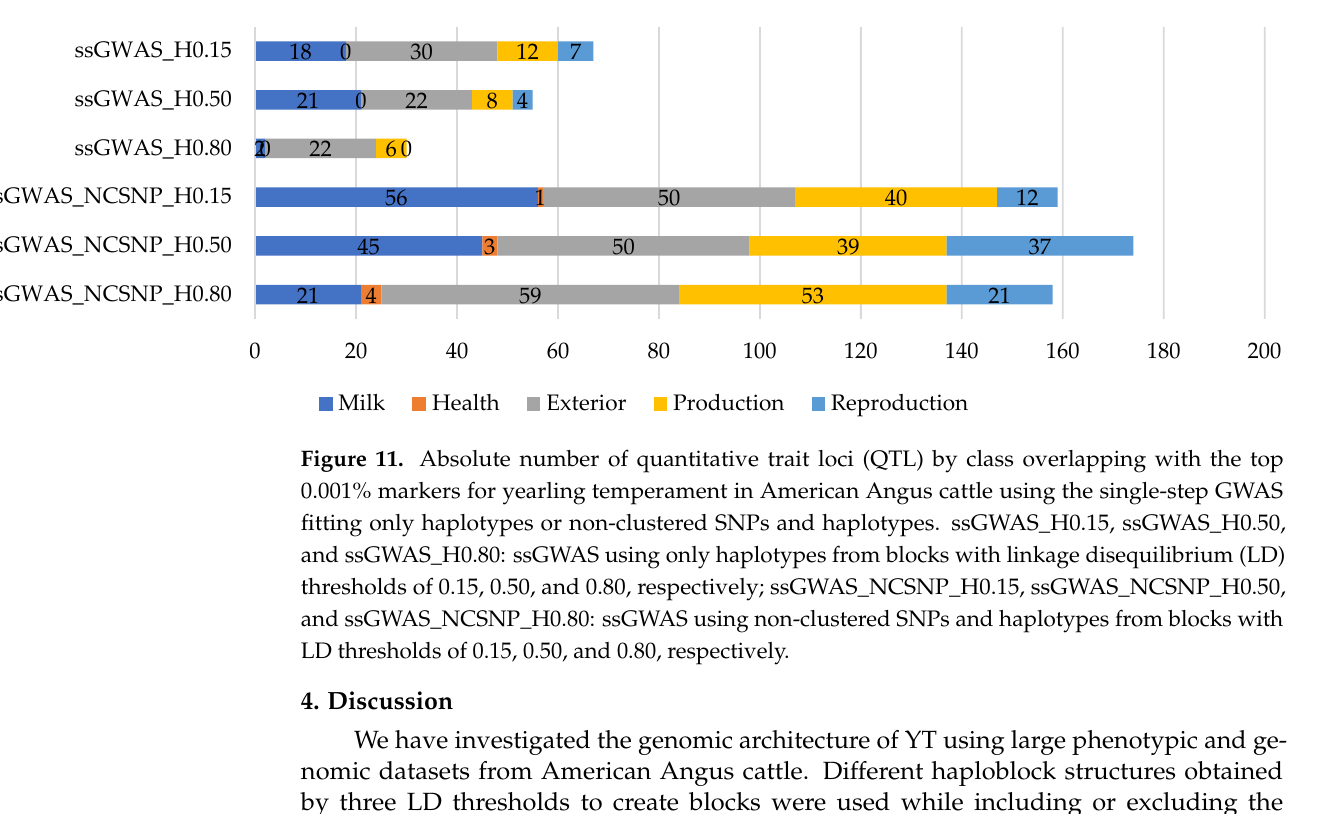
18 of 28 Figure 10. Venn diagrams showing the number of QTL overlapping among different single-step genome-wide association studies (ssGWAS) with haplotypes and non-clustered SNPs. ssGWAS_H0.15, ssGWAS_H0.50, and ssGWAS_H0.80: ssGWAS using only haplotypes from blocks with linkage disequilibrium (LD) thresholds of 0.15, 0.50, and 0.80, respec- tively; ssGWAS_NCSNP_H0.15, ssGWAS_NCSNP_H0.50, and ssGWAS_NCSNP_H0.80: ssGWAS using non-clustered SNPs and haplotypes from blocks with LD thresholds of 0.15, 0.50, and 0.80, respectively. The QTL identified by the scenarios evaluated in this research belong to the classes “Milk”, “Health”, “Exterior”, “Production”, and “Reproduction” (Figure 11). The majority